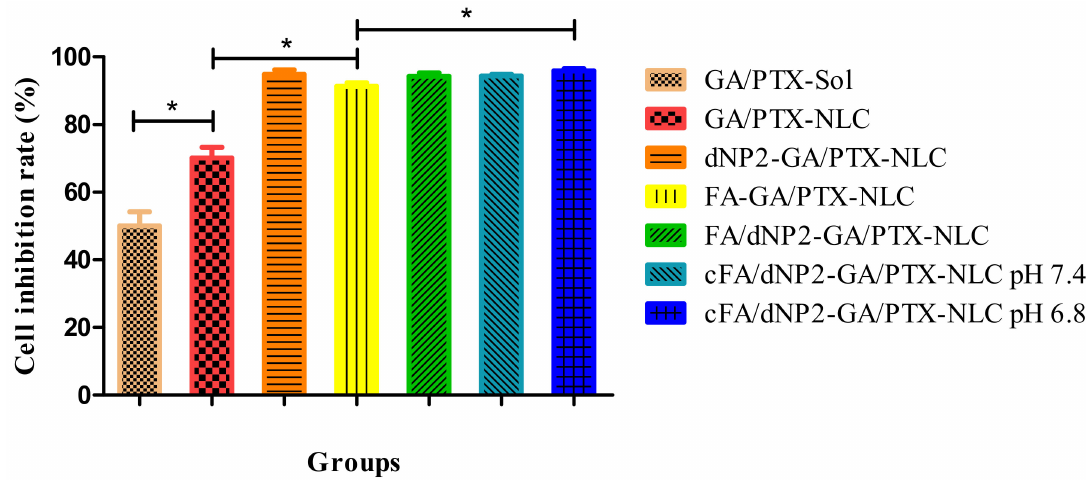
Figure 7. The cell viability of different formulations was analyzed by Cell Counting Kit 8 (CCK-8). Results are expressed as mean ± SD, n = 3. * p <